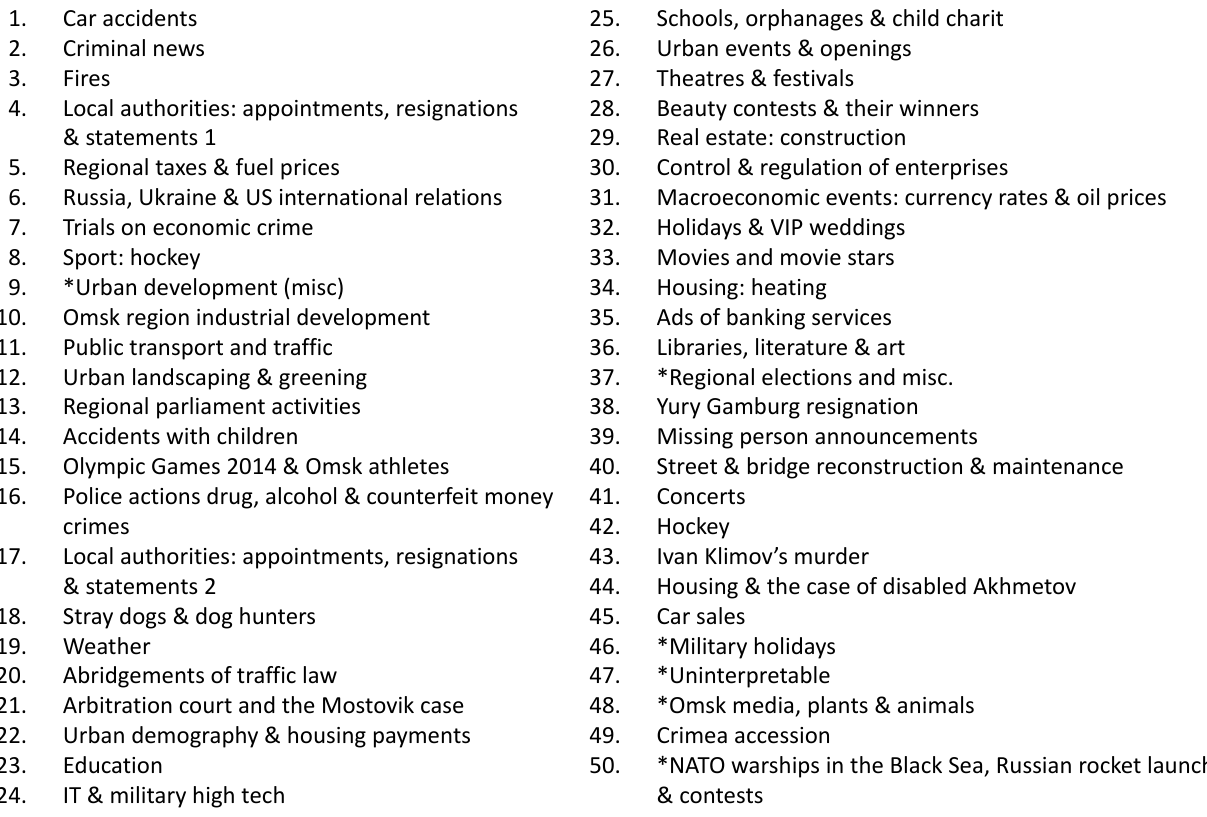
Table 1. Topics ranked by salience (max = 0.0478; min = 0.0032; mean = 0.0198; stdev =